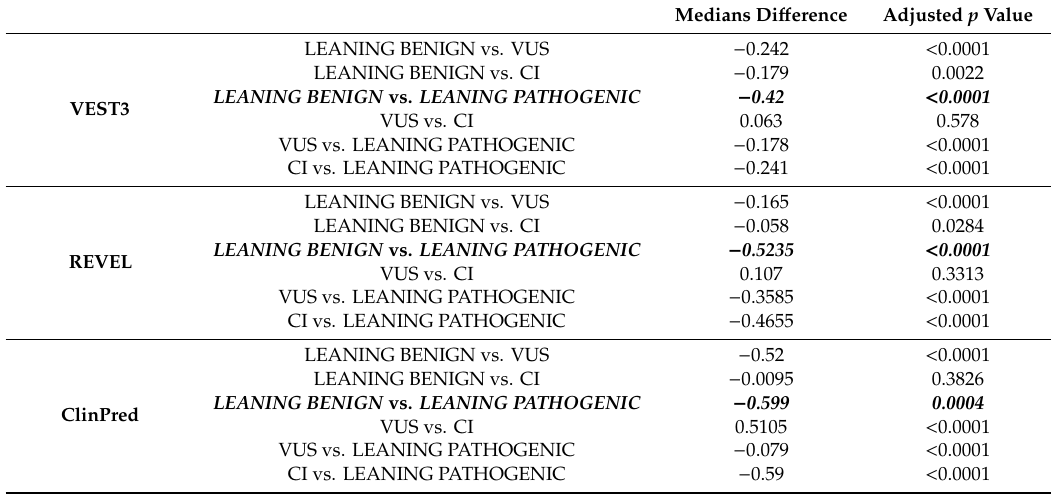
Table 2. Pairwise comparison between scores of variants with di ff erent classification at ClinVar. Results of Dunn’s test corrected for multiple comparisons with the Benjamini-Hochberg method are shown. In bold and italics are highlighted results of pairwise comparisons between the LEANING BENIGN and LEANING PATHOGENIC categories showing the widest medians di ff erence for all the three